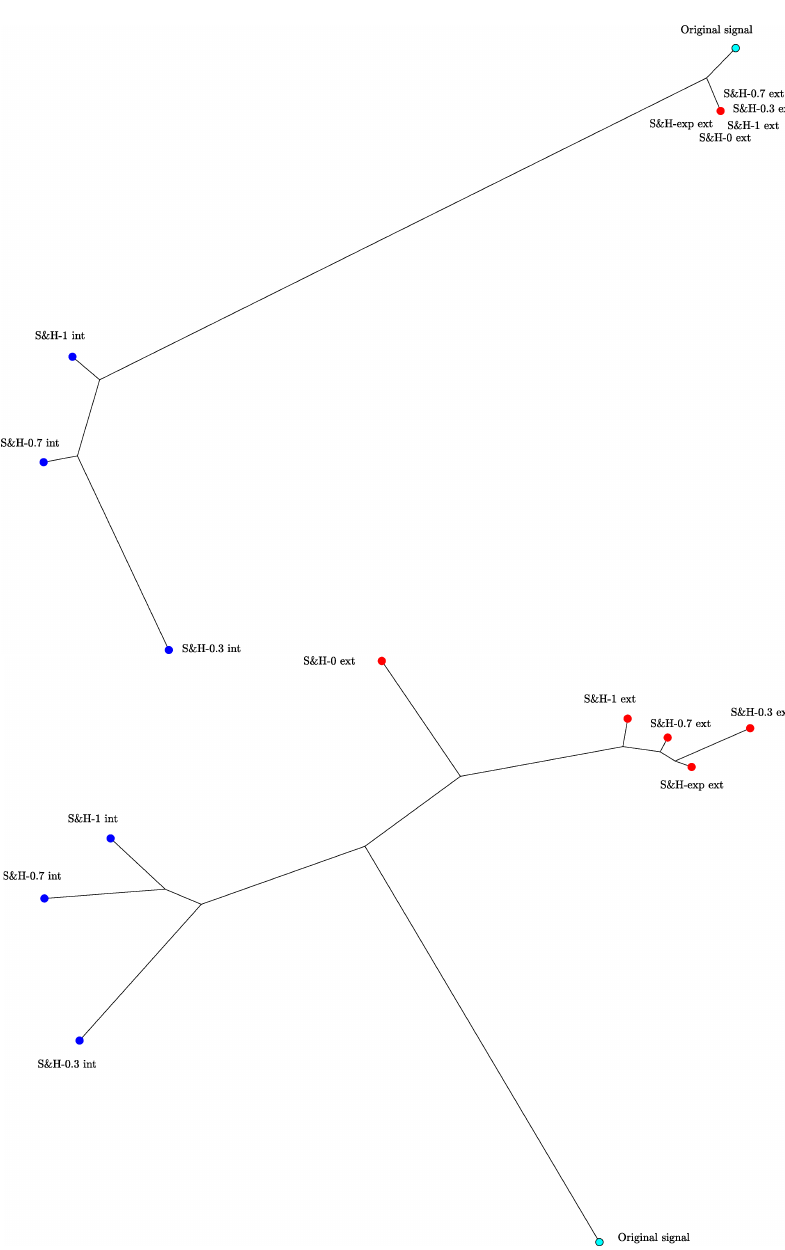
Figure 3. The HC trees using the Euclidean and Canberra distances, for the frequency response of the extrapolations of the S&H-0, S&H- α (with α = 0.3 and α = 0.7), S&H-1 and S&H-exp (with τ = 200) and interpolations with S&H- α (with α = 0.3 and α = 0.7) and the